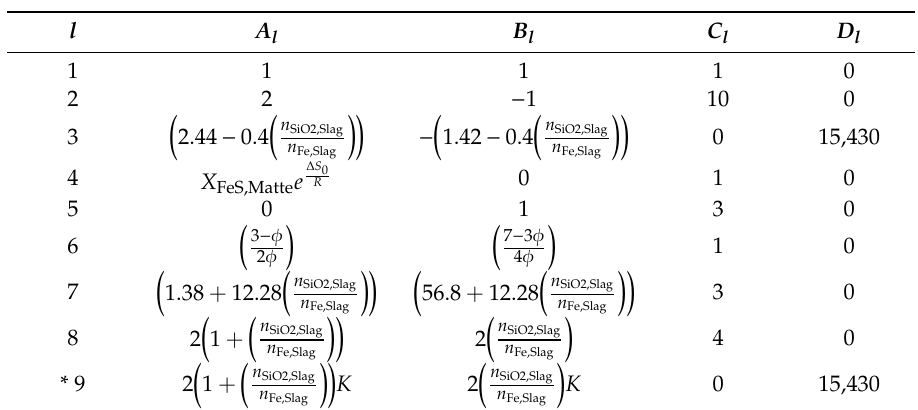
Table A1. Coe ffi cients for Equation (A2) (adapted from